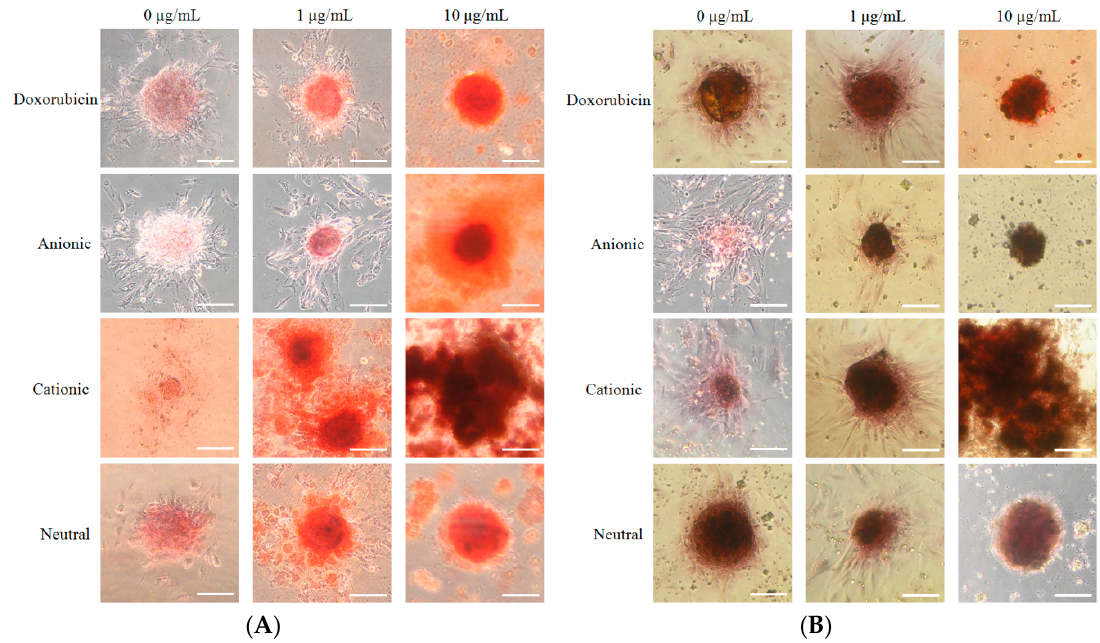
Figure 5. ( A ) The results of the Alizarin Red S staining on Day 7 (original magnification ×200). The scale bar indicates 100 μ m. ( B ) The results of the Alizarin Red S staining on Day 14 (original magnification ×200). The scale bar indicates 100 μ m.